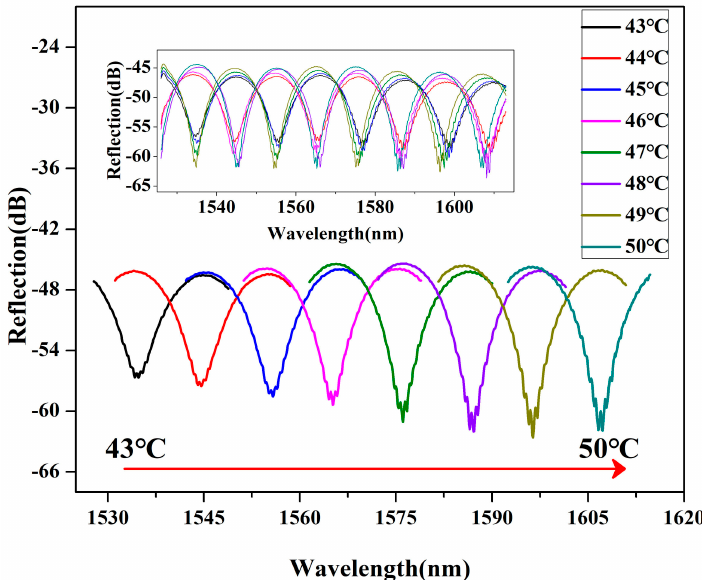
Figure 4. Reflection spectra of the microfiber Fabry-Perot temperature probe for the temperature increased from 43 °C to 50 °C with a step of 1 °C.